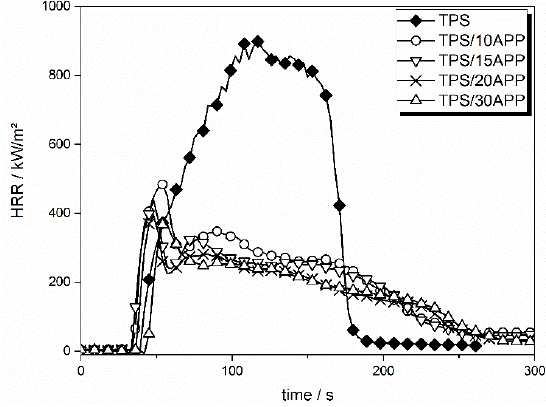
Figure 12. HRR curves of TPS formulations with APP.